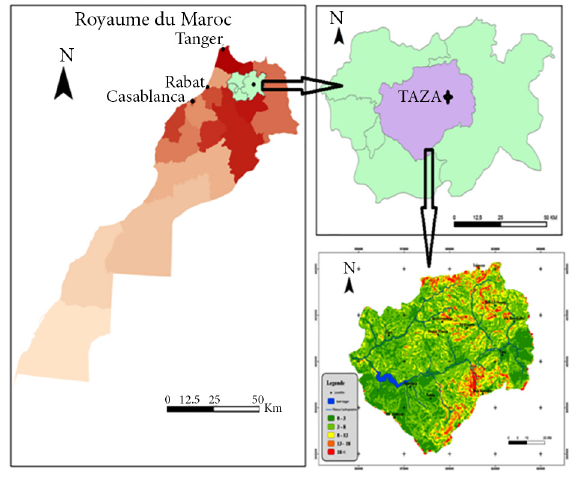
Figure 1. Geographical location of the study area